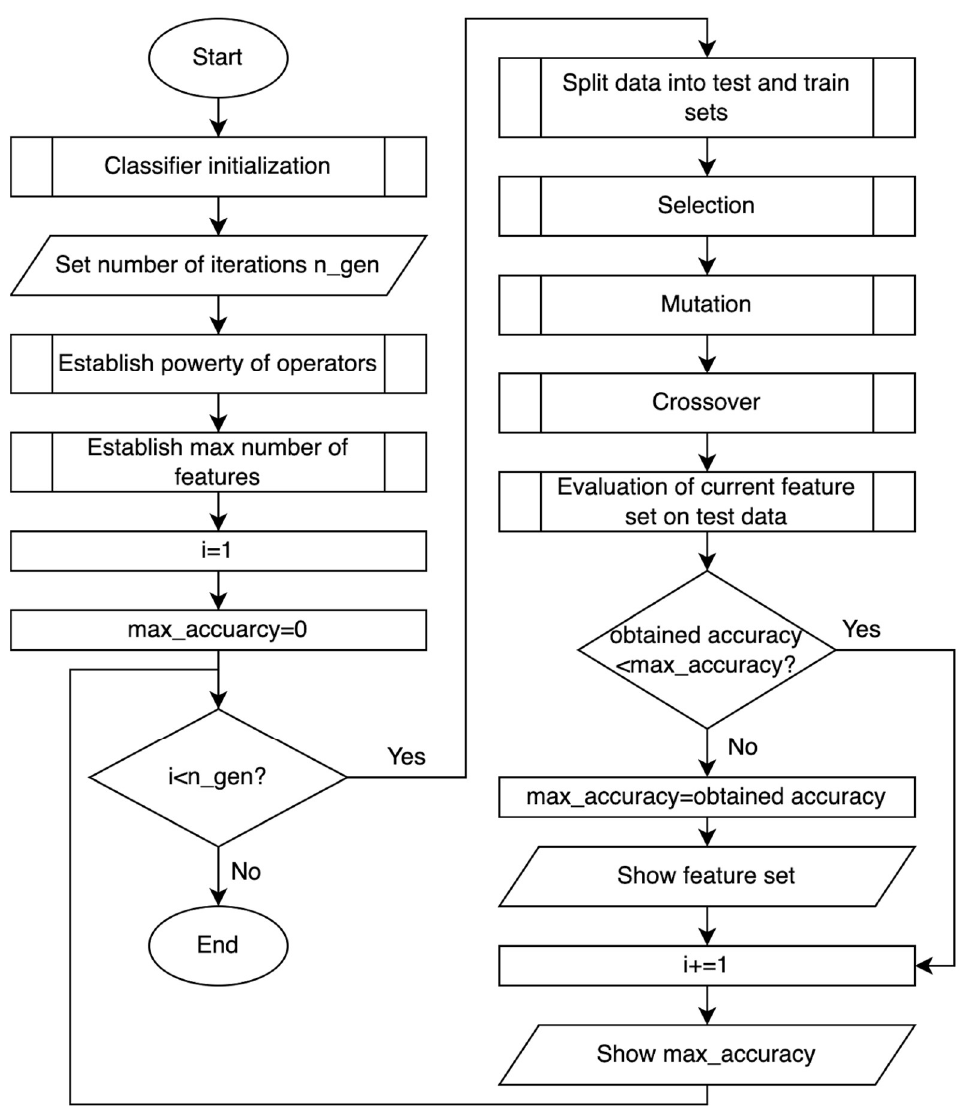
Figure 1. Genetic Algorithm block diagram. Algorithm 2. RbFS